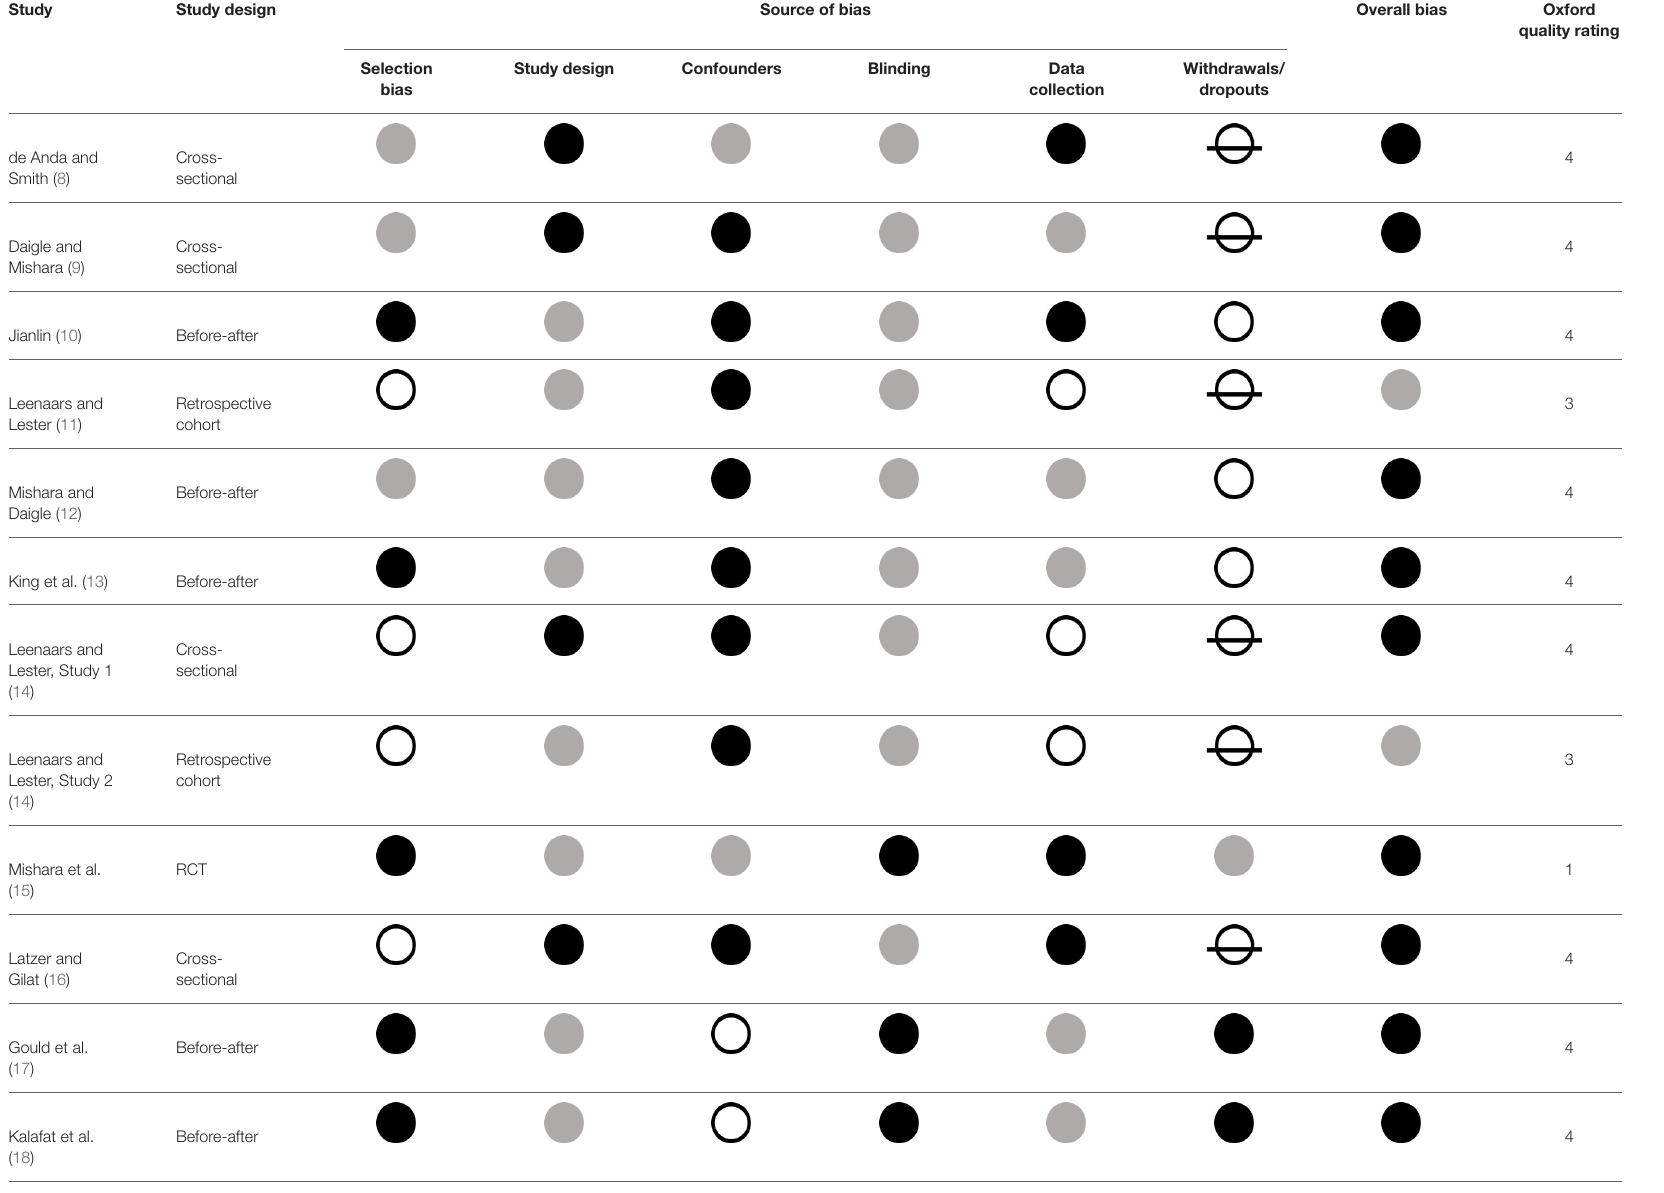
TABLE 1 | Design, sources of bias, overall bias, and oxford quality rating by